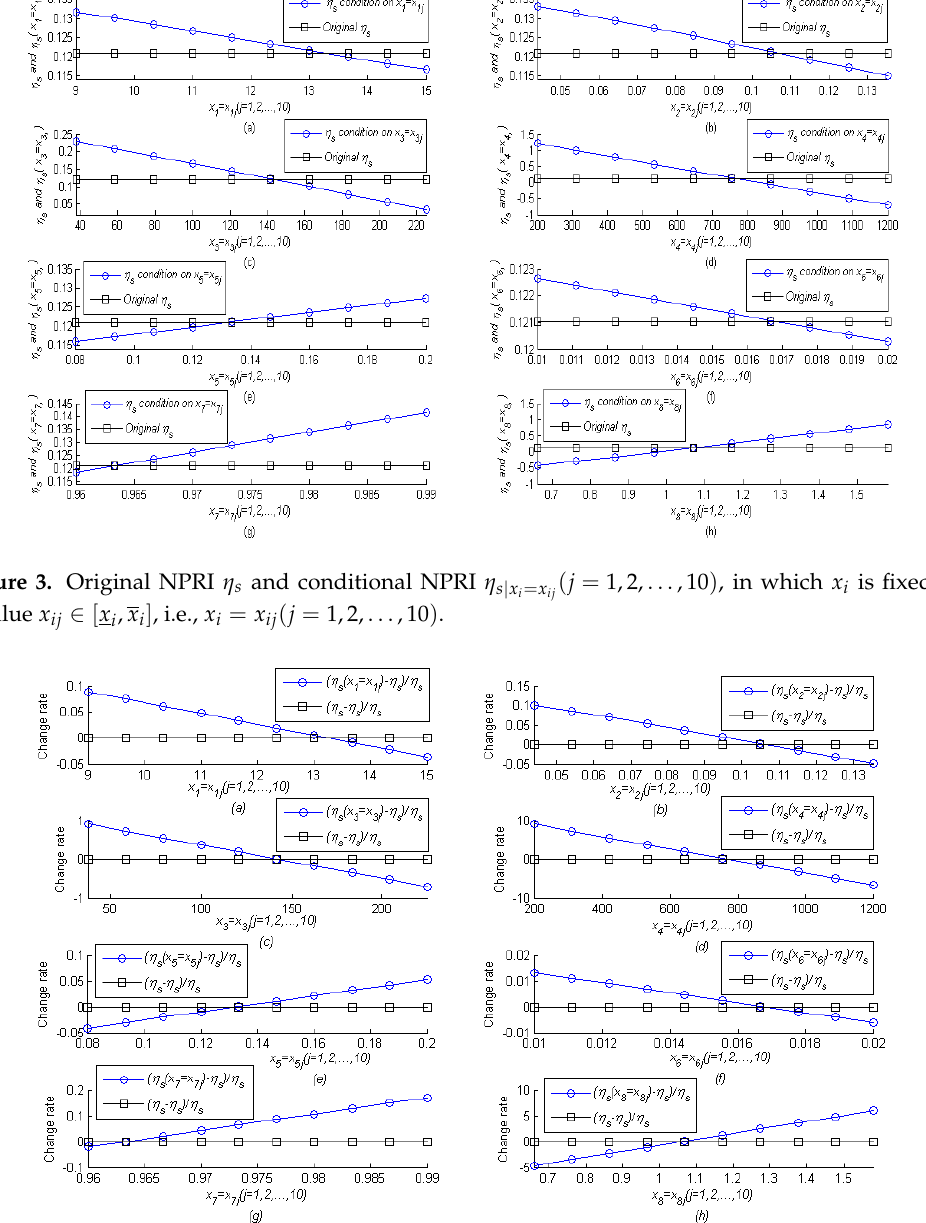
Figure 4. Change rate between η s | x and in which x i is fixed to a value x ij ∈ [ x i , x i ] , i.e., x i = x ij